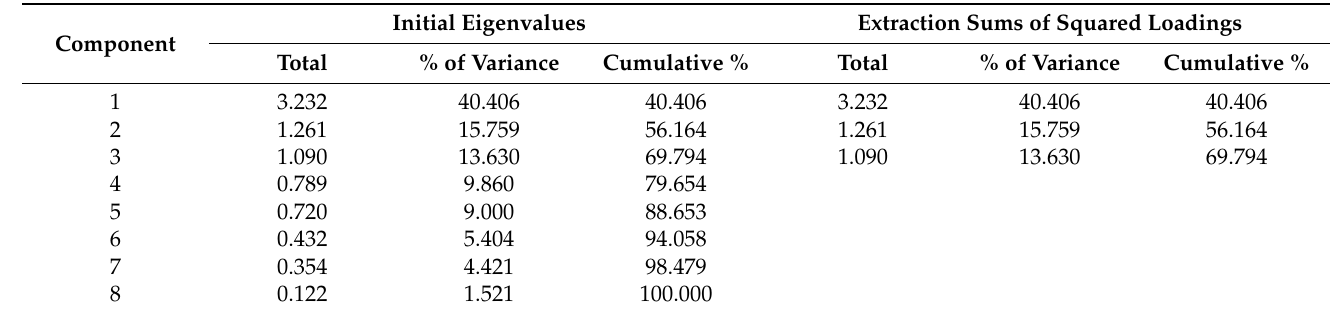
Table 4. Explanation of total variance.